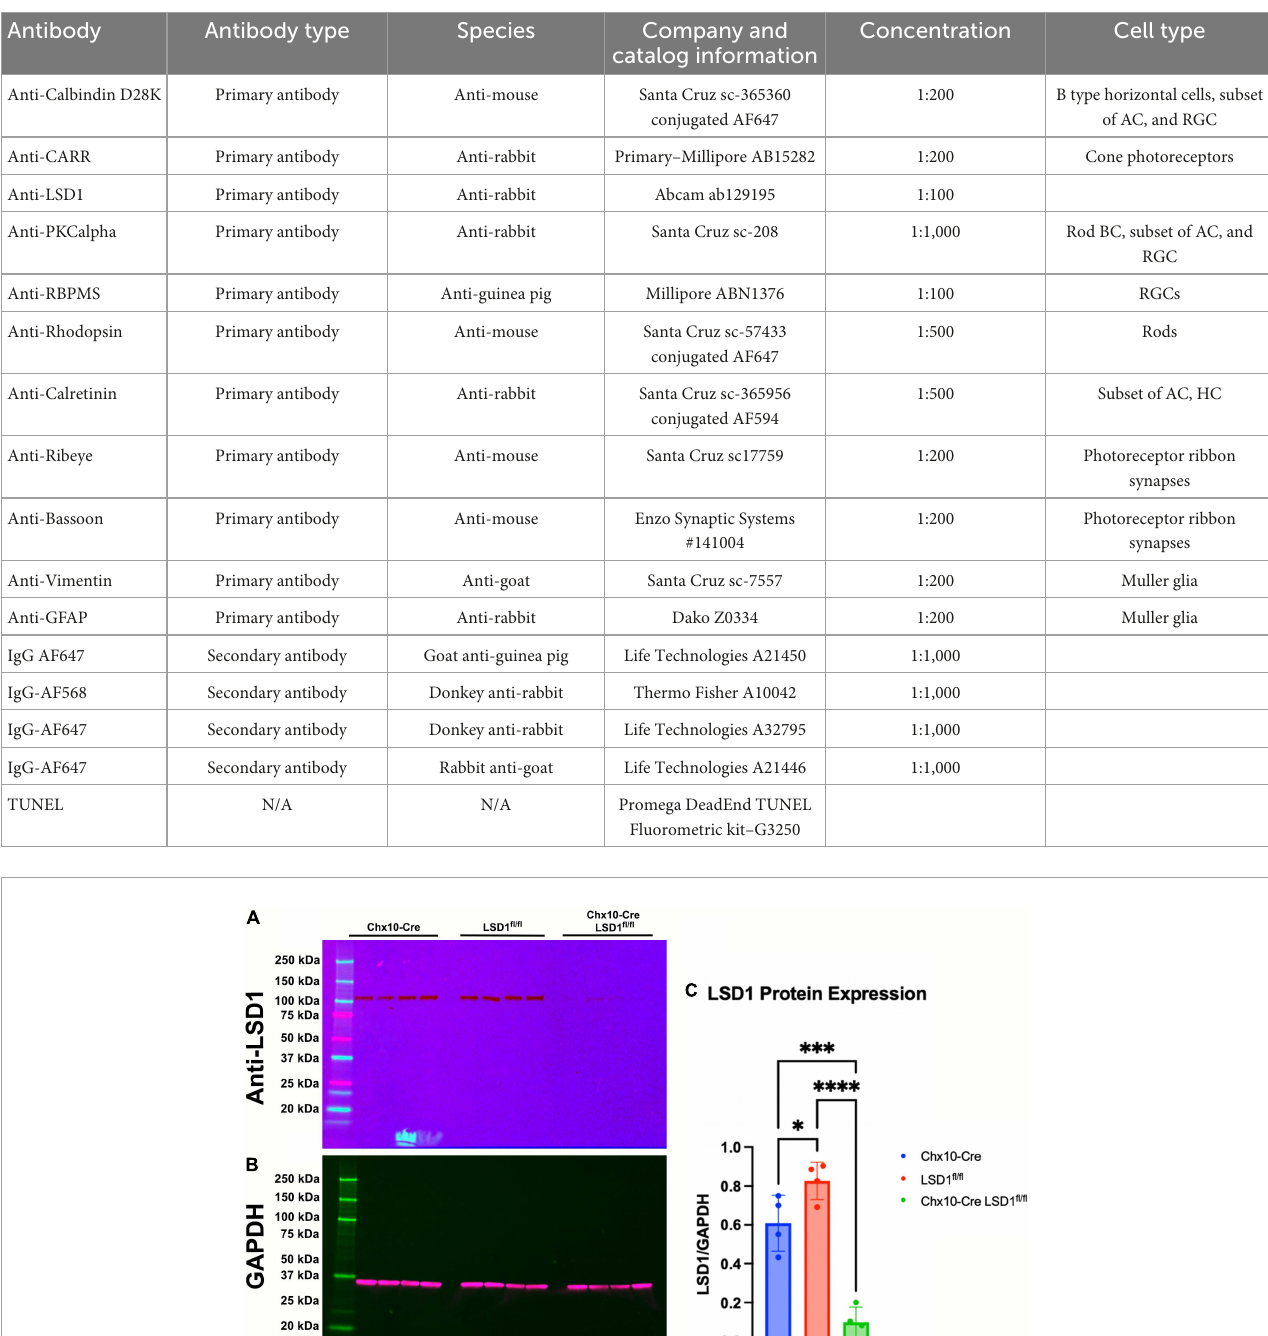
TABLE 1 Antibody characteristics and sources.